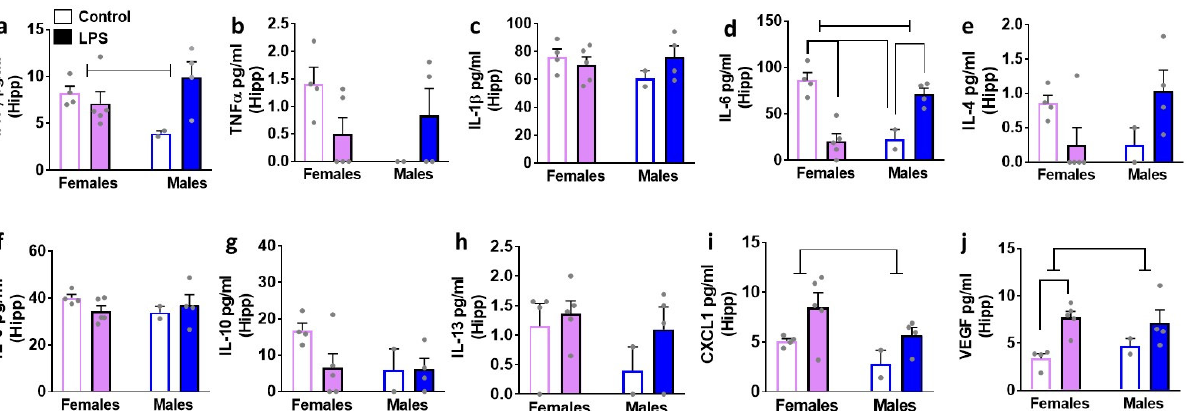
Figure 6. Cytokines, chemokines, and VEGF were measured in the hippocampus (Hipp) of female and male rats that were exposed to saline or LPS challenges. Pro-inflammatory cytokines are indicated in panels ( a – d ). Anti-inflammatory cytokines are indicated in panels ( e – h ). Chemokine is indicated in panel ( i ) and angiogenesis marker is indicated in panel ( j ). Data are represented as mean ± S.E.M. n = 4 control female, n = 5 LPS female, n = 2 control male, n = 4 LPS male. Interaction ( p < 0.05) is indicated by a solid straight line with arrowheads, main effect of LPS ( p < 0.05) is indicated by solid line with flat arrowheads, and main effect of sex ( p < 0.05) is indicated by dashed line with flat arrowhead. Differences between saline and LPS within each sex and between sexes ( p < 0.05) are indicated by separate solid lines.